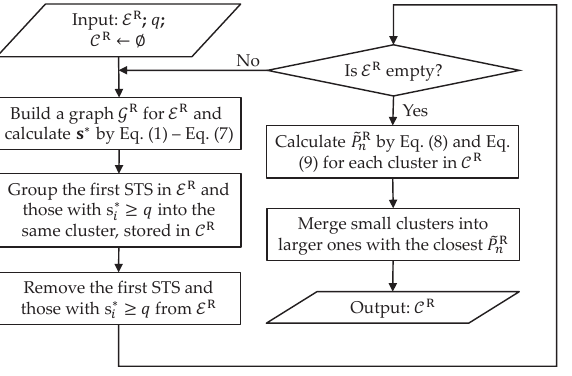
Figure 2. Flow chart of GSP-based STS clustering, where (.)* denotes the optimized